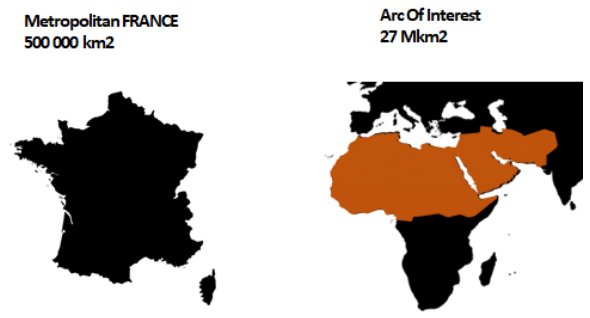
Figure 2. E2p demonstration areas